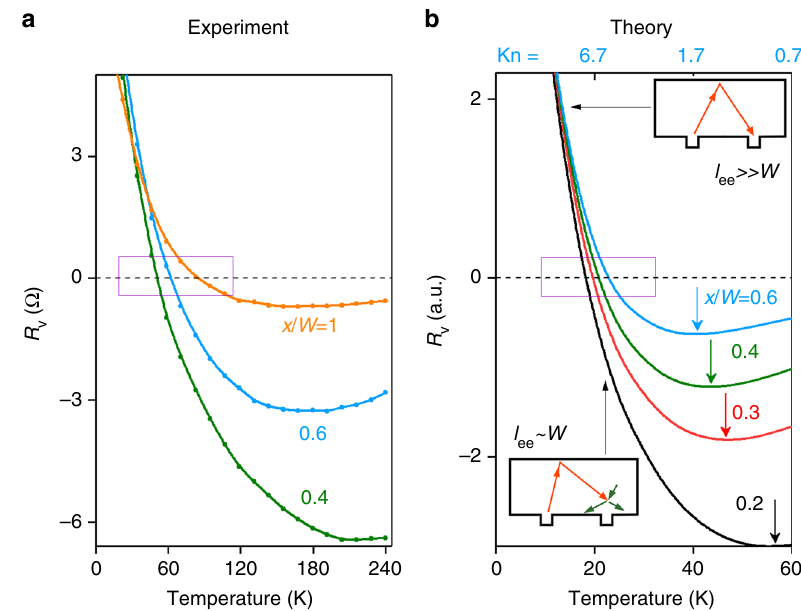
Fig. 3 Vicinity resistance versus T for several positions x of the voltage probe. a Experimental R v ( T ) for n = 1.5 × 10 12 c m − 2 and W = 2.3 μ m. b Theoretical dependence R v ( T ) predicted from the kinetic equation for the device in Fig. 1a. Temperature enters through the ee scattering rate (cid:1) h γ axis corresponds to the electron Knudsen number Kn = l ee / x calculated for the blue curve. The purple rectangles and arrows mark, respectively, the sign change and minima in the R v ( T ) dependences. Upper inset: Schematics of electron transport in the ballistic regime. The potential at the source is transported by carriers throughout the sample and into the probe. Lower inset: Schematics of the voltage sign change in the quasiballistic regime. Collisions between injected carriers (red arrows) and ambient thermal carriers (green arrows) diminish the number of thermal carriers reaching the probe. This reduces the potential, which reverses its sign and becomes negative. Arrows link the insets with the corresponding portions of the R v ( T )